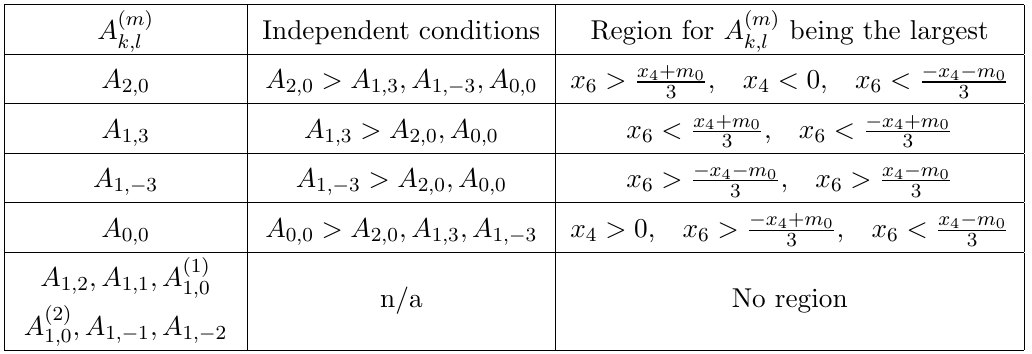
Figure 10. The blue letter A ( m ) the boundaries of those regions and give the 5-brane web in the decompacti(cid:12)cation limit of the curve in Region 4